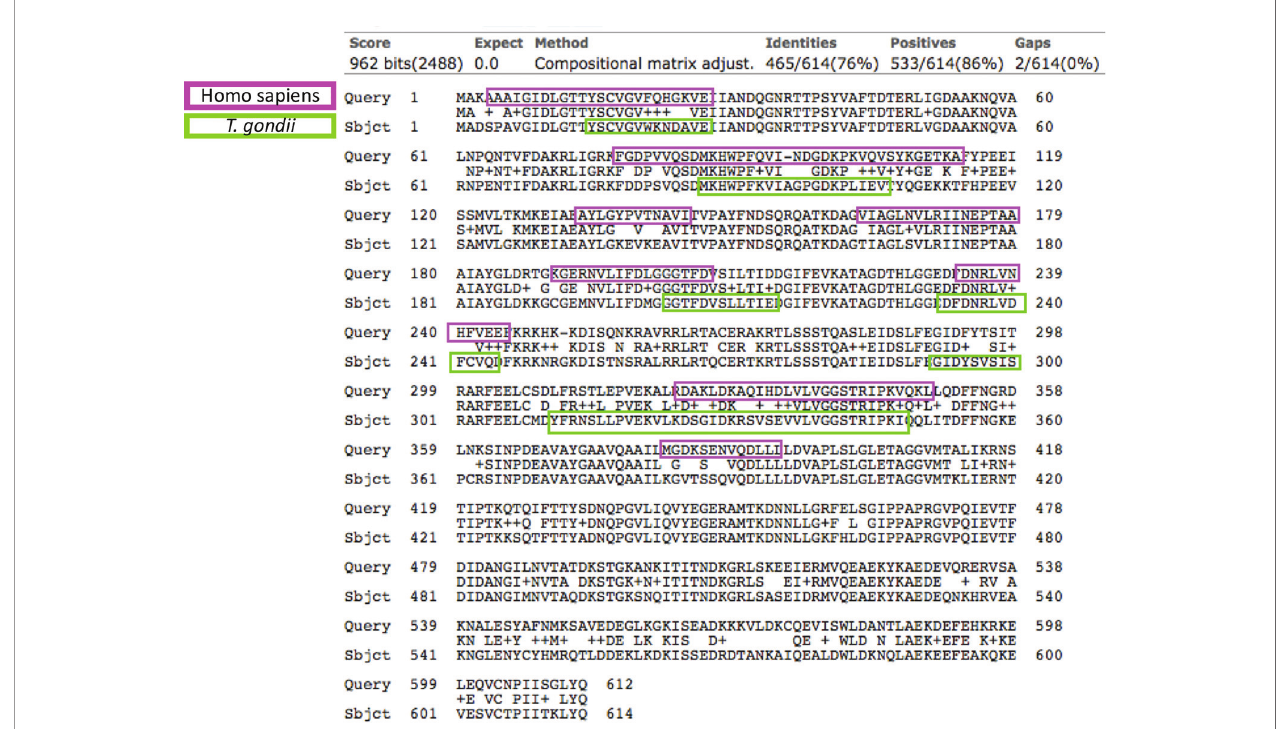
FIGURE 1 | Sequence alignment of the Homo sapiens (upper rows) and T. gondii HSP70s (lower rows). In the middle lines are the matching amino acids. The identity between the sequences was 76% (yellow circle), in lilac and green colors are the B antigenic determinants predicted for the respective sequences. The arrows indicate the antigenic determinants that both proteins